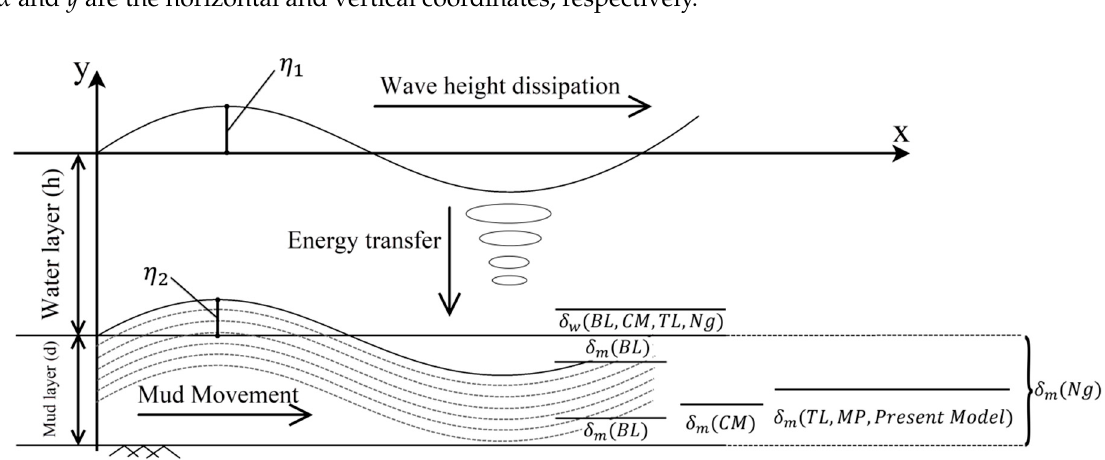
Figure 1. Sketch of the wave-mud interaction for different models; (Modified from Haghshenas and Soltanpour [16]).